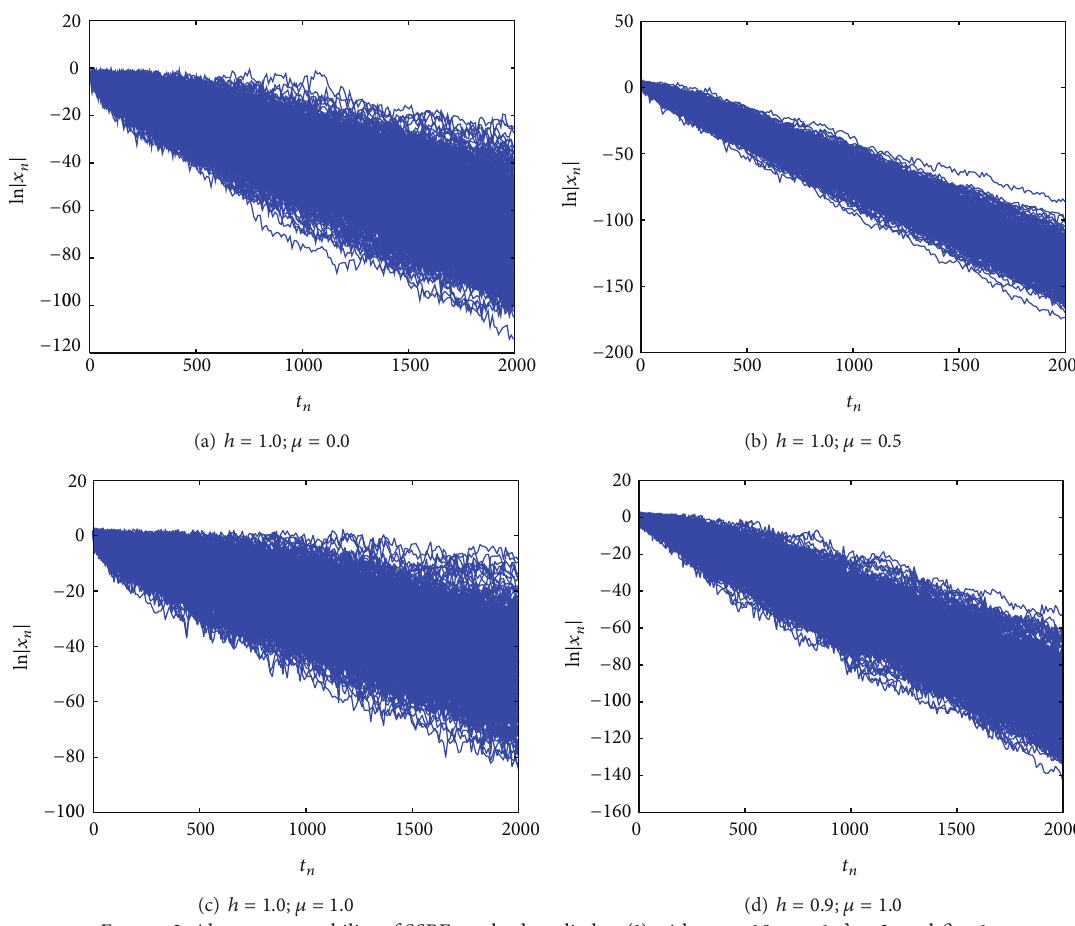
Figure 2: Almost sure stability of SSBE method applied to (1) with 𝛼 = −10 , 𝜎 = 1 , 𝜆 = 3 , and 𝛽 = 1